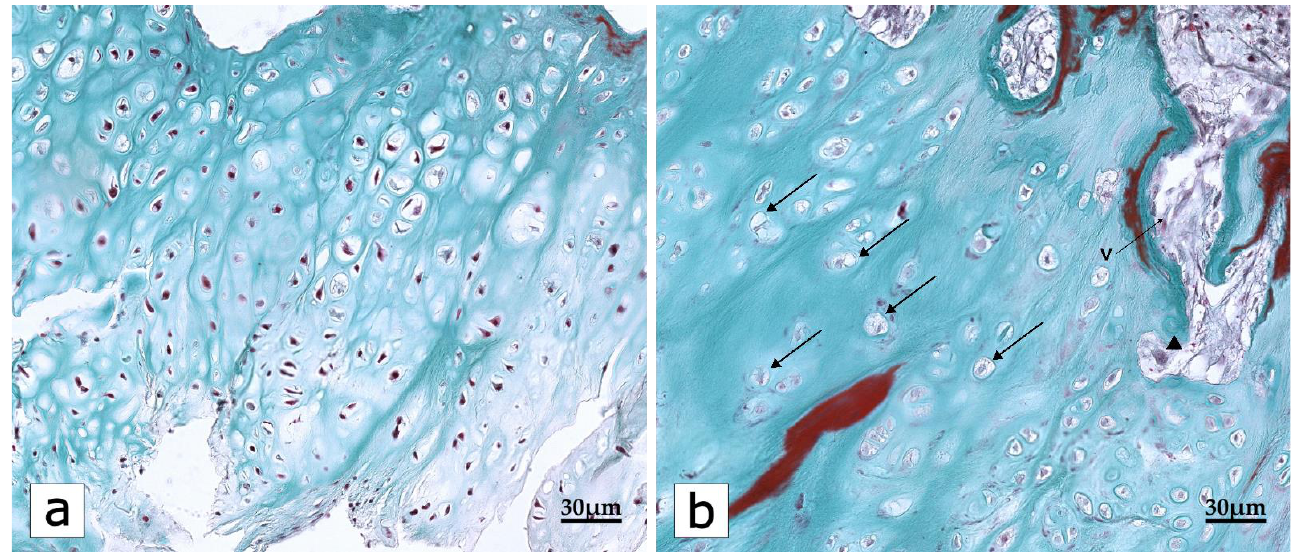
Figure 2. A representative image that depicts the OA-associated changes in Safranin O/Fast green stained section of articular cartilage. ( a ) Degradation of cartilage and changes in the proteoglycan content, as indicated by the lack of orange – red staining, is evident. ( b ) Enlarged, hypertrophic chondrocytes contain abundant cytoplasmic inclusions (arrows). Deep vascular invasions (V) into the cartilage matrix and reactive chondroclasts (arrowheads) are evident. Safranin O/Fast green staining. Scale bars: 30 μm.